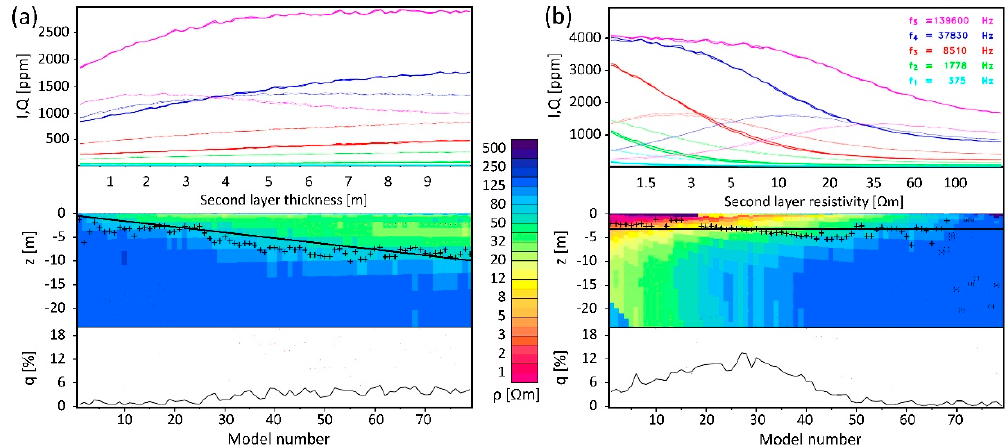
Figure 7. Results of a modeling study showing, from top to bottom: noisy five-frequency HEM data (I and Q before and after inversion), 1D inversion models (colors), and steepest gradient analysis ( + ), as well as the misfit q of the inversion. Models: Cover layer ( ρ 1 = 200 Ω m, d 1 = 0.25 m), variable layer ( a ) model 1 ( ρ 2 = 35 Ω m, d 2 = 0.25–10 m) and ( b ) model 2 ( ρ 2 = 1–200 Ω m, d 2 = 3 m), underlying half-space ( ρ 3 = 150 Ω m). The thick black lines indicate the top of the half-spaces.